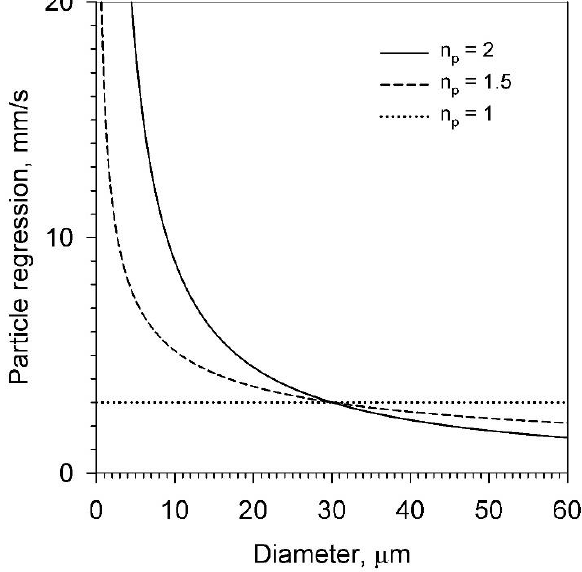
Figure 2. Predicted particle regression rate for n for n = 1.5 ( k = 4.93 × 10 −5 m 1.5 /s) and for n p r